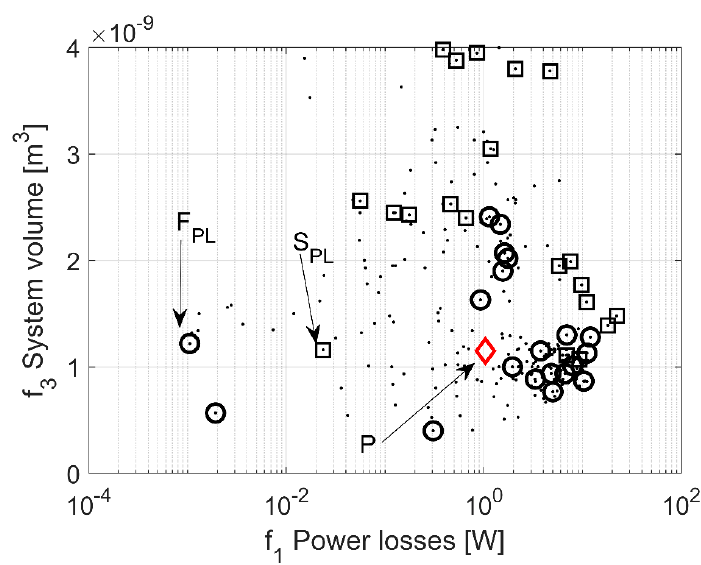
Figure 10. f 1 –f 2 projection of the objective space: dot—individuals, square—starting points, circle—final solutions.